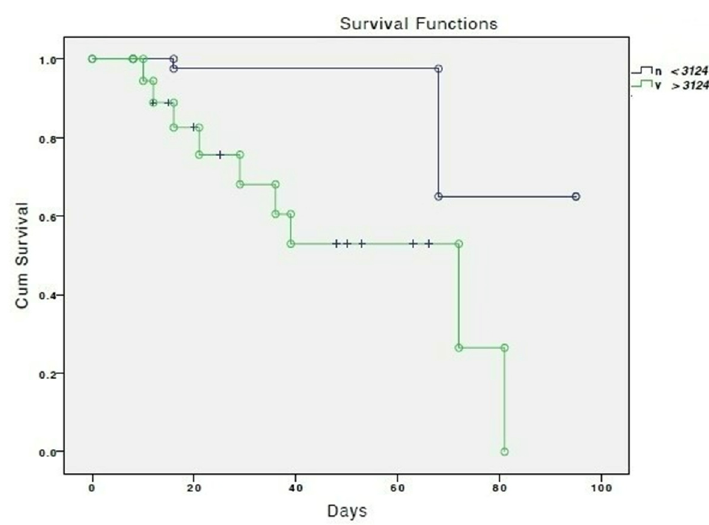
Figure 1. Cumulative survival according to serum norepinephrine levels lower (green line) and higher or equal (blue line) to 3124 ng/mL. “+” means censored.